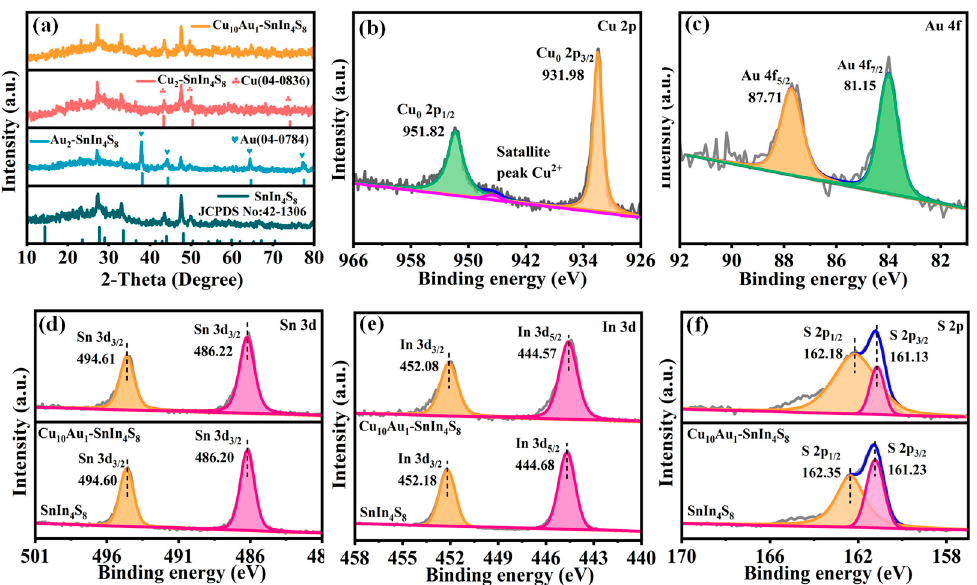
Figure 3. ( a ) XRD patterns of the as-prepared samples. XPS spectra for ( b ) Cu 2p and ( c ) Au 4f of Cu 10 Au 1 -SnIn 4 S 8 , ( d ) Sn 3d, ( e ) In 3d and ( f ) S 2p of SnIn 4 S 8 and Cu 10 Au 1 -SnIn 4 S 8